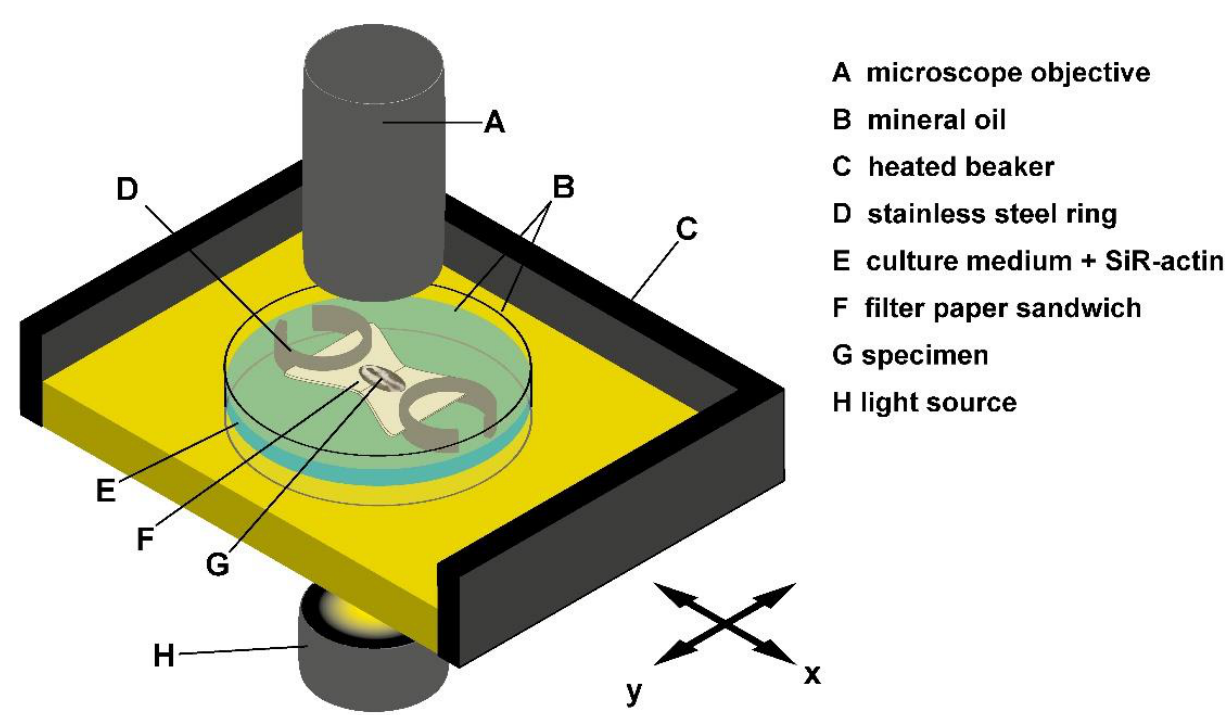
Figure 1. Live fluorescence imaging using the Submerged filter paper sandwich. Schematic view of the experimental setup. The embryo is stabilized by two layers of filter paper and kept fully submerged in the culture medium at all times. SiR-actin can diffuse into the tissue from the culture medium. A layer of light mineral oil prevents evaporation. The heated beaker is filled with mineral oil as well. The sample is illuminated through the glass bottom of the beaker and imaged from above.